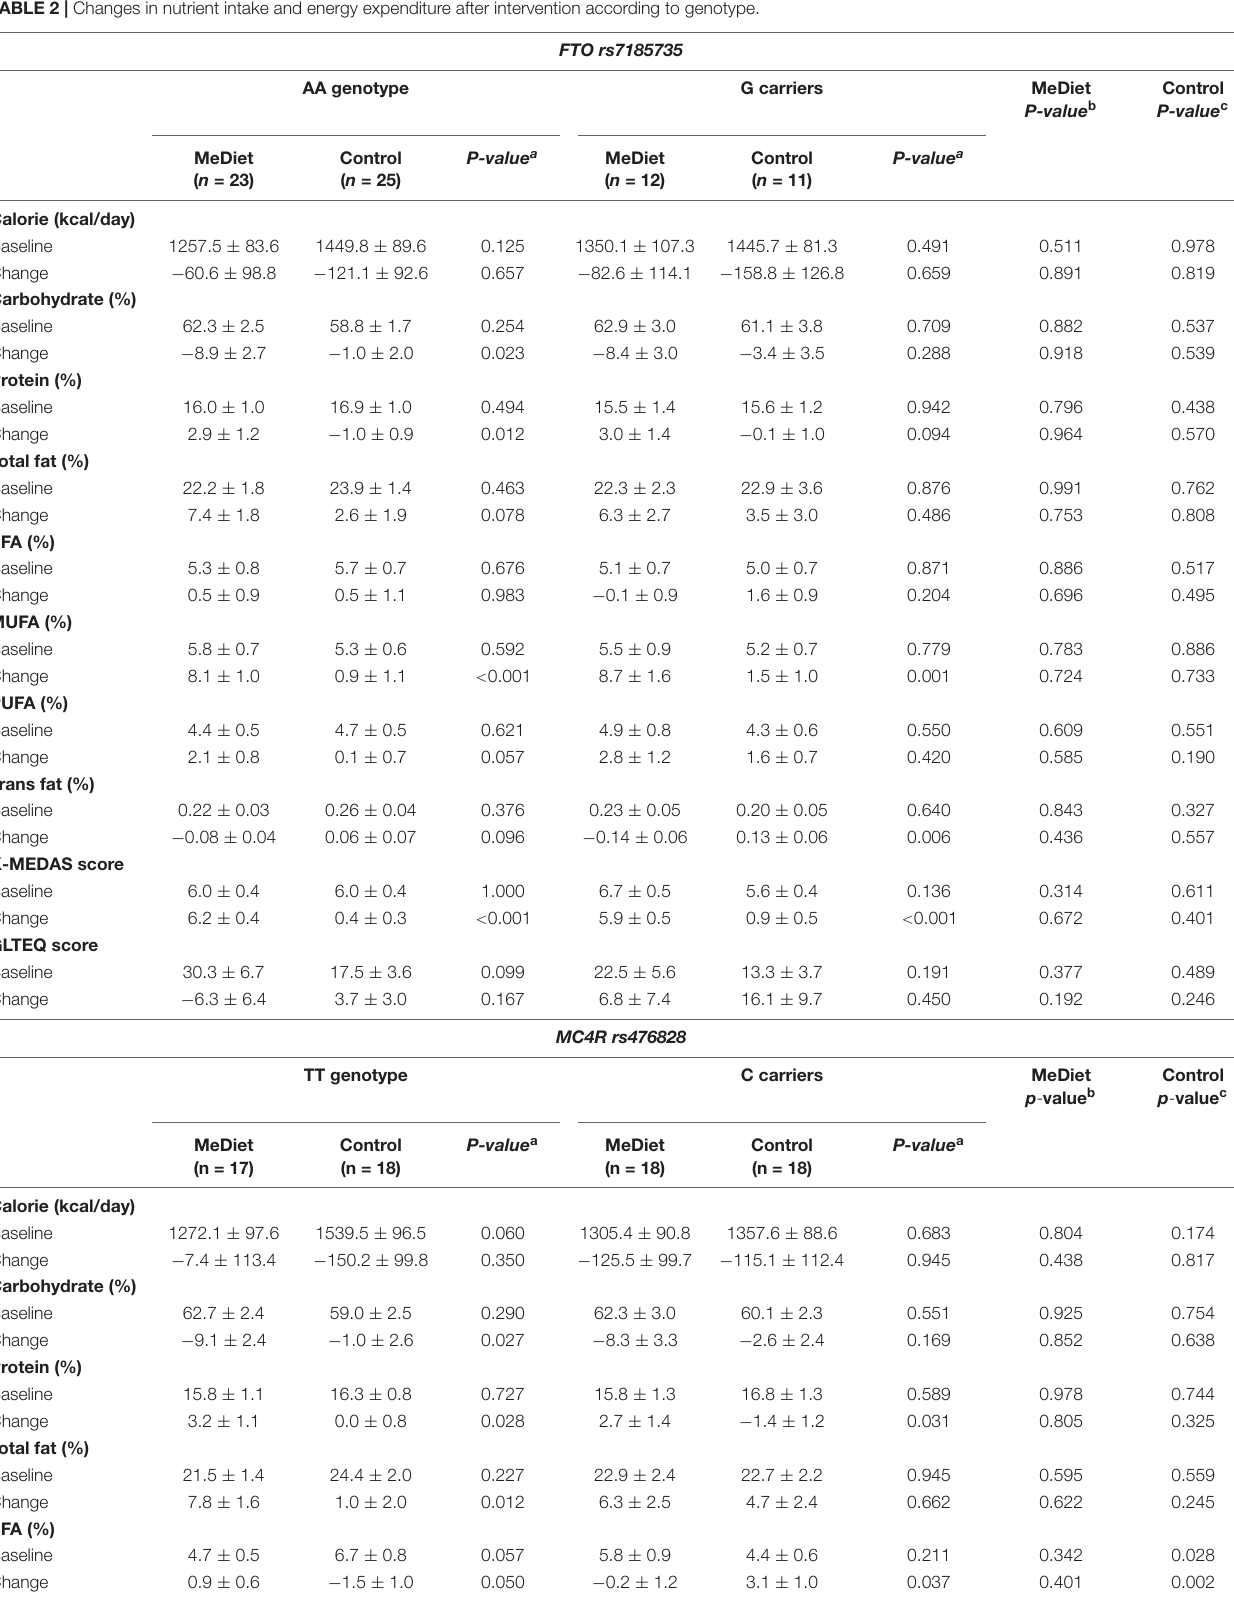
TABLE 2 | Changes in nutrient intake and energy expenditure after intervention according to